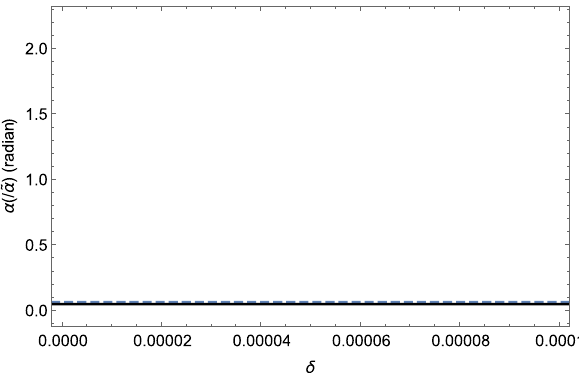
Fig. 3 The plot shows the behavior of the two conformally related deflection angle profiles w.r.t δ < 1 when 2 GM is normalized to unity c 2 r c (> 1 ) . The solid (Black) curve cor- for the scaled impact parameter, ξ r c responds to α , whereas the dashed curve corresponds to ˜ α . Here, the left wing of both deflection angle curves ( α and ˜ α ) seems to be conformally consistent for δ (cid:4) 1